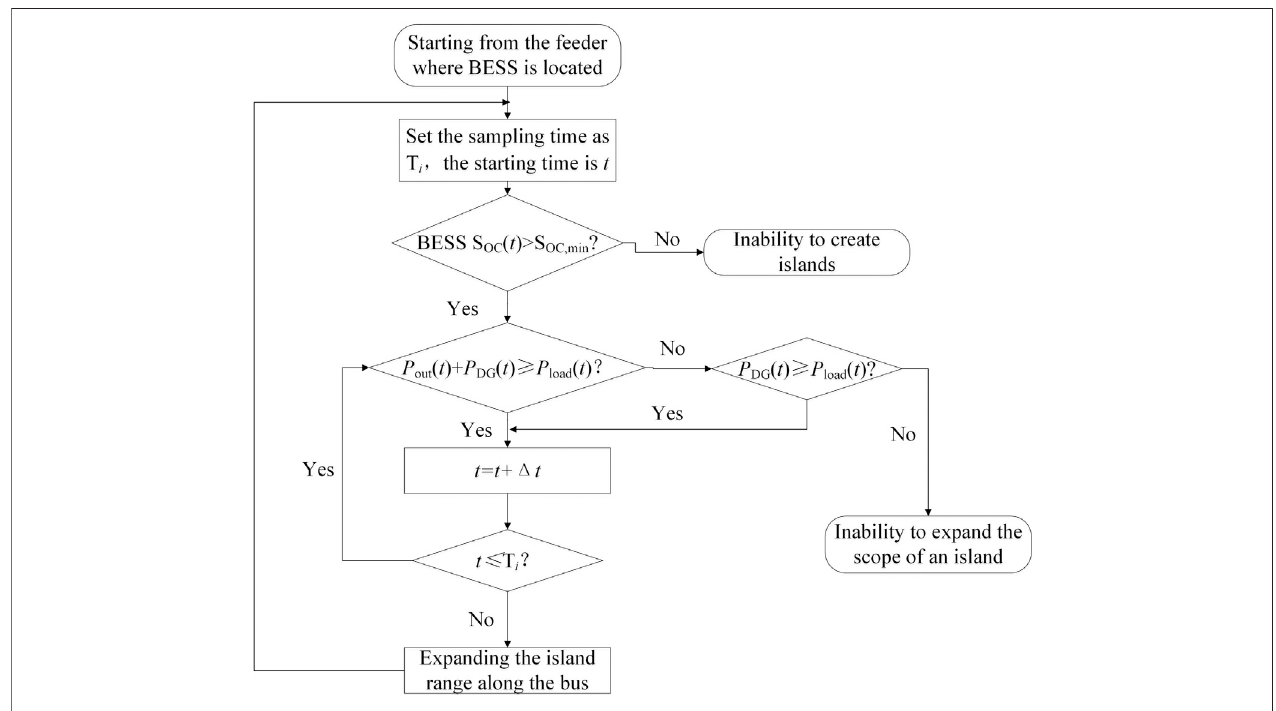
FIGURE 1 | Process of islanding division.